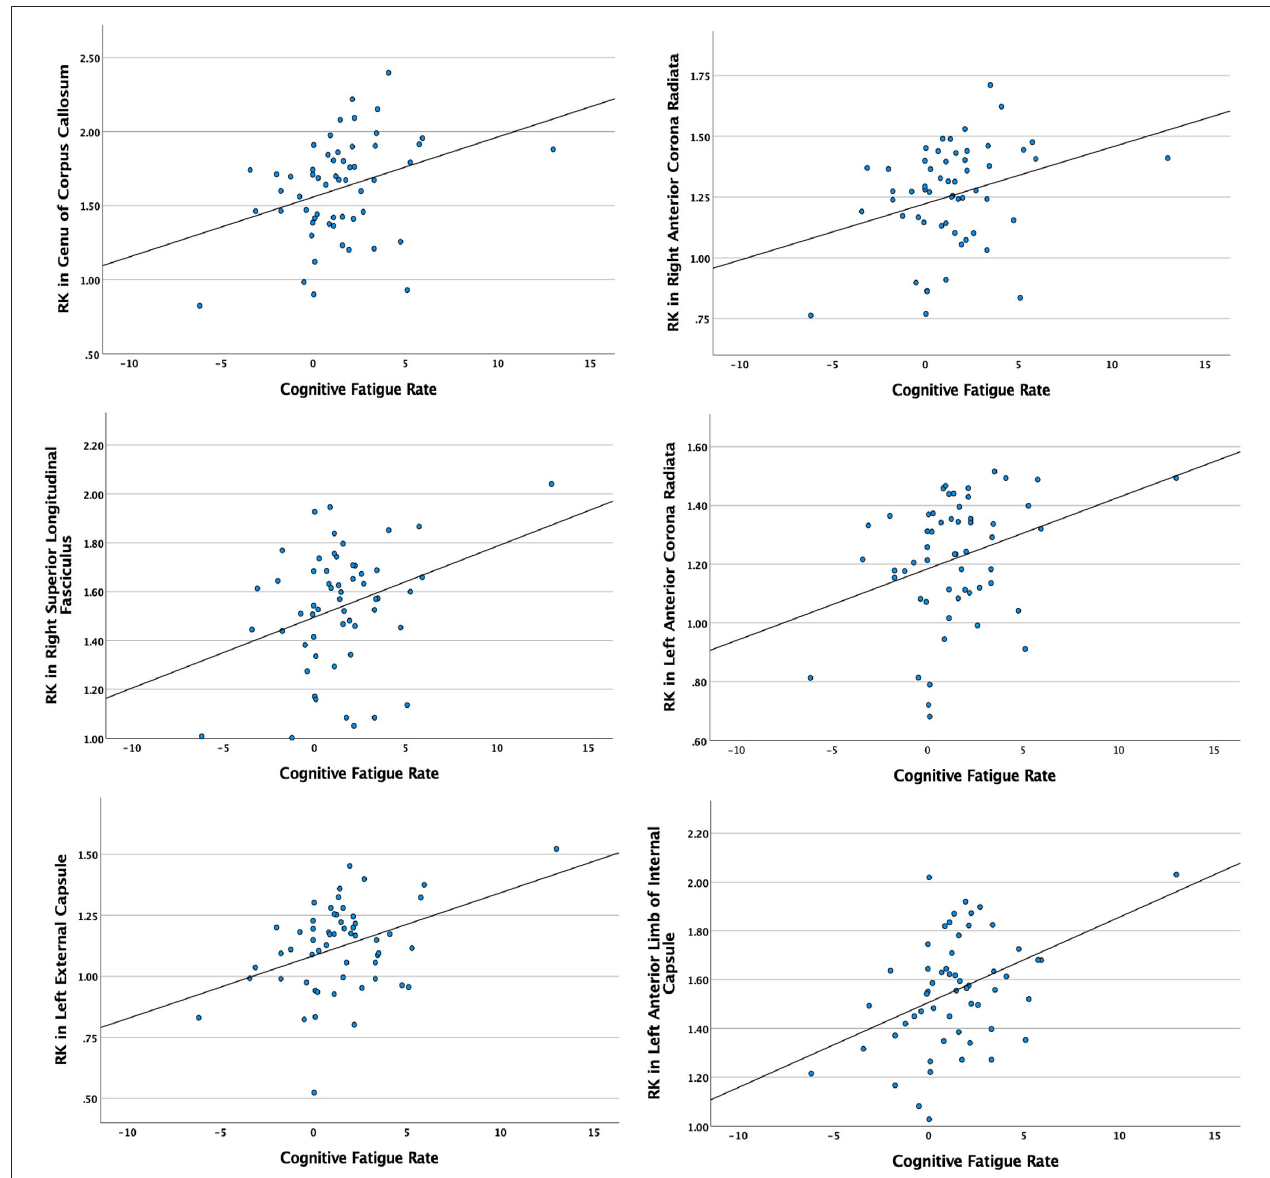
FIGURE 2 | Scatterplots demonstrating the linear relationship between cognitive fatigue rate and radial kurtosis (RK) in tracts with the six greatest volumes of significant clusters. Y-axes = RK in significant white matter tracts. X-axes = cognitive fatigue rate. Analyses were conducted with and without apparent outliers without significant changes in